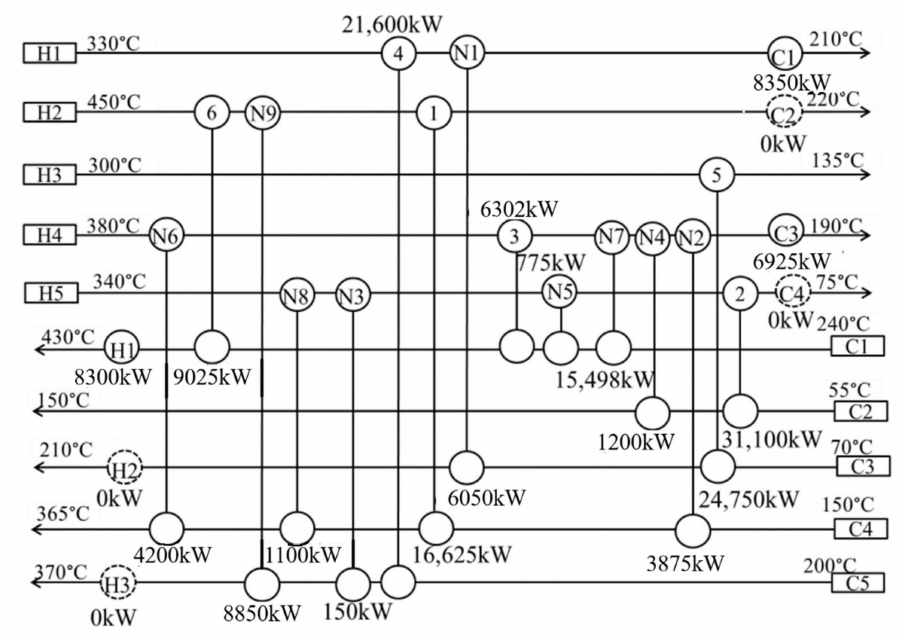
Figure 25. Best retrofit solution for case study 3 with application of conventional heat exchangers. Table 7. The comparison results of two different